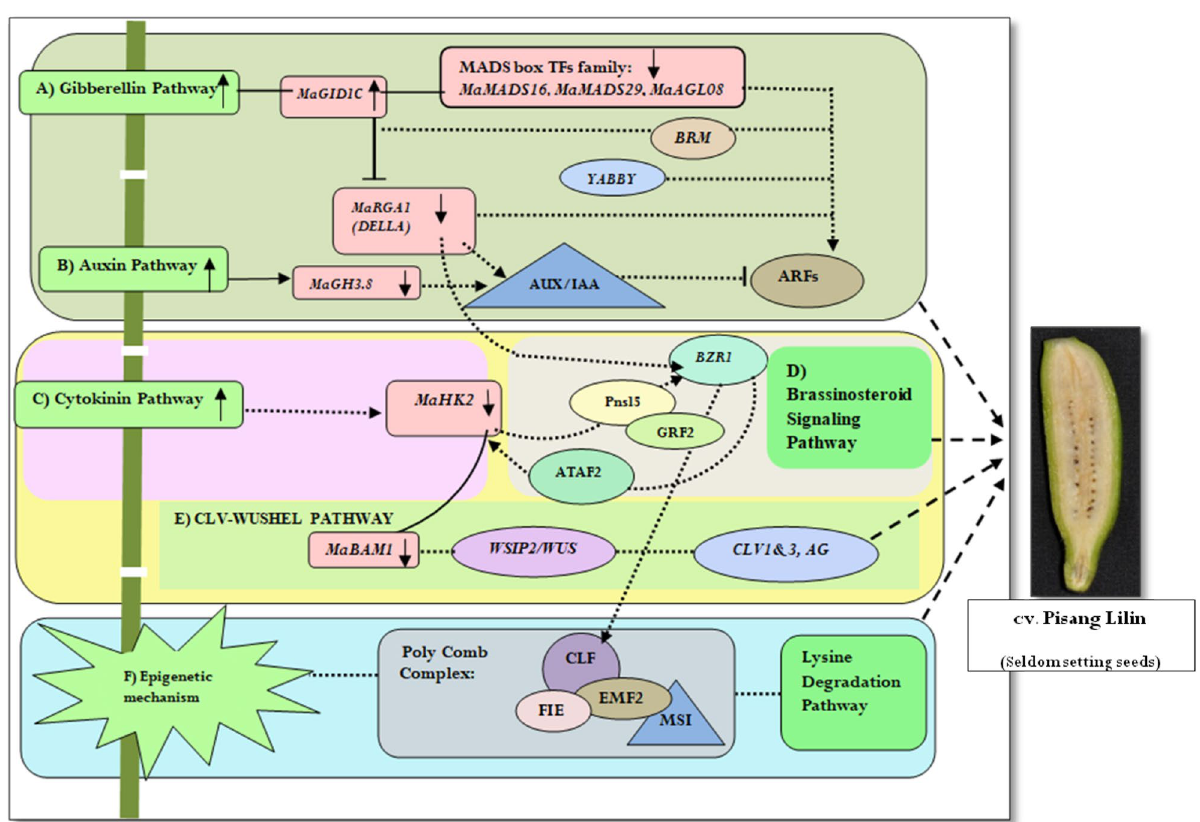
Figure 6. Putative pathway for natural parthenocarpy in Musa spp. ( A–C ) Increase in auxin, GA and Cytokinin induces parthenocarpic fruit formation by down regulating the expression of MADS box TFs ( MaAGL8, MaMADS16, MaMADS29 ), MaRGA1 (DELLA), MaHK2 and MaBAM1 . MADS box TFs, MaRGA1 and BZR1 c ould act as a focal point in auxin mediated GA response in parthenocarpy. ( D ) Genes related to brassinosteroid signaling pathway ( BZR1 ) get interacts with Pnsl5 and GRF2 act asa bridge between MaHK2, MaBAM1 and CLV-WUS signaling pathway that induces seedless fruit formation. ( E ) CLV-WUSHEL signaling pathway where WSIP2 is the wushel interacting protein get interacts with WUS , CLV1 , AG and thereby associated with MaBAM1 which issignificantly down regulated in parthenocarpic accession cv. Pisang Lilin . ( F ) Group of poly comb proteins ( CLF, FIE, EMF2, MSI— histone modifying enzymes) which arereported to be involved in epigenetic mechanism of reproductive development. Their association to MaBAM1 (involved in male/female gametophyte development) and CLV speculated their role in seedless fruit formation. KEGG analysis also highlighted that these genes are involved in lysine degradation pathway. Green color box indicates hormonal signaling pathway and epigenetic mechanism that are predicted to mediate seedless fruit formation; Dotted arrow lines represents the putative flow and the association of interaction partners to the validated genes which is derived from the constructed PPI network; Highlighted genes in rounded rectangle boxes along with ↓ symbol indicating down regulated expression pattern in cv. Pisang linin upon pollination (P24) in the current study. Highlighted gene in rounded rectangle boxes along with ↑ Symbol indicated increased expression pattern MaGID1C in cv. Pisang Lilin. Genes mentioned in the triangle boxes are literature derived genes where corresponding supporting evidences were given in the discussion section.Genes mentioned in the oval boxes are retrieved based on their interaction with candidate genes in the constructed PPI network; Where expression of these genes MaAGL8, MaMADS16, MaMADS29 , MaRGA1 (DELLA), MaHK2, MaBAM1, MaGID1C, MaGH3.8 (mentioned in the pathway) were validated in three cultivars C4, CVR and PL of Musa to silencing PIN (an auxin efflux transport protein) in tomato 42 . Upon critical evaluation of BRM, BZR1, GH3.8, GID1C and DELLA for its association with MADS box TFs and ARFs in the PPI network, we proposed direct or mediated interactions of MADS box TFs, and ARFs with DELLA , BRM, GH3.8, GID1C and BZR1 speculat- ing GA mediated auxin signaling in seedless fruit formation (Fig. 6A,B). Besides GAs and auxin, cytokinin and brassinosteroids (BRs) also plays a critical role in parthenocarpic fruit development, however the hormonal crosstalk associated with these hormones remains mysterious. Significant down regulation of MaBAM1 par- ticularly in seedless accession (PL) made us to look into theinteraction partners of BAM1 - CLV3, CLV1, CPI1 and their connectedness to other hubs in the network. To our surprise, interaction of CLV1 with Pnsl5, BZR1, WSIP2 (WUS-interacting protein 2) and GRF2 explored its association with HK2, MADS TFs and ARFs (Sup- plementary Fig. S4B). Though association of HK2 with BAM1 is not elusive, an earlier study based on comparative genomic approaches in Musa spp.reported the role of HK2 in gametophyte development 67 and another study